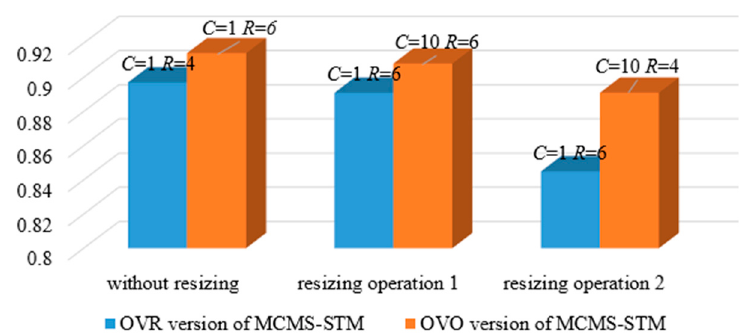
Figure 9. The classification accuracies of MCMS-STM with or without different image resizing operations.